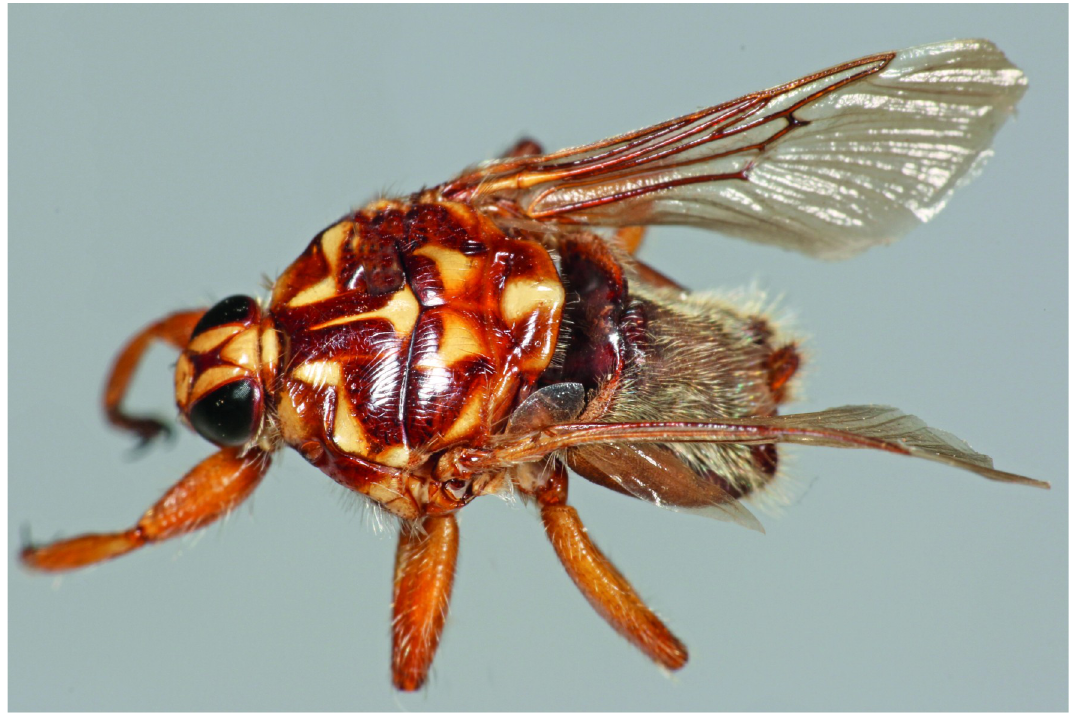
Fig 2. Hippobosca camelina . Hippobosca camelina was present: (i) in all of the camel herds surveyed, (ii) throughout the year, and (iii) nearly all camels in the herds were infested by keds.